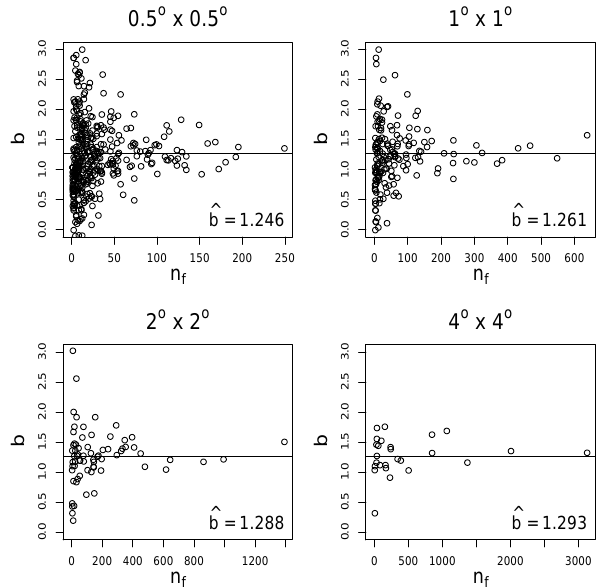
Fig. 3. Plots of estimated values of parameter b against fire counts, n f , for all four resolutions. The solid lines horizontal lines are at b = ¯ b for the values of ¯ b shown on each